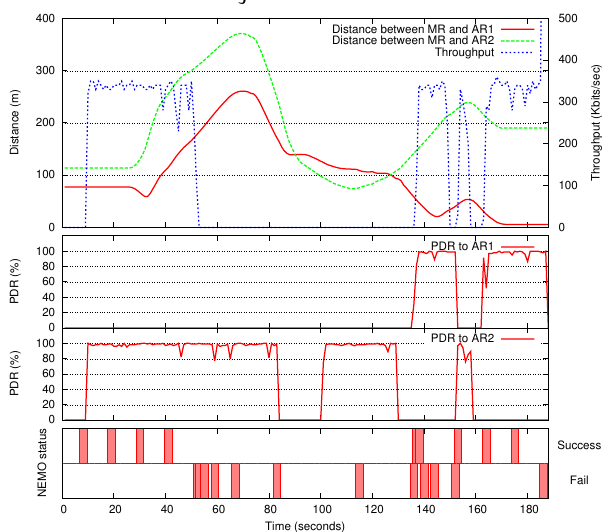
Figure 11. Map-based PDR of UDP evaluation using NEMO over IPv6 GeoNetworking